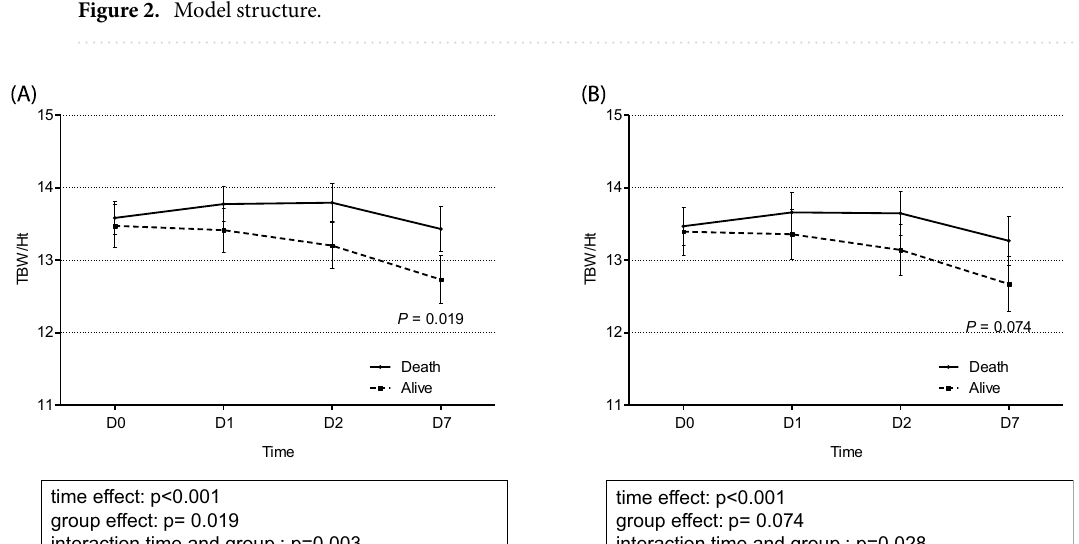
Figure 2. Model structure.